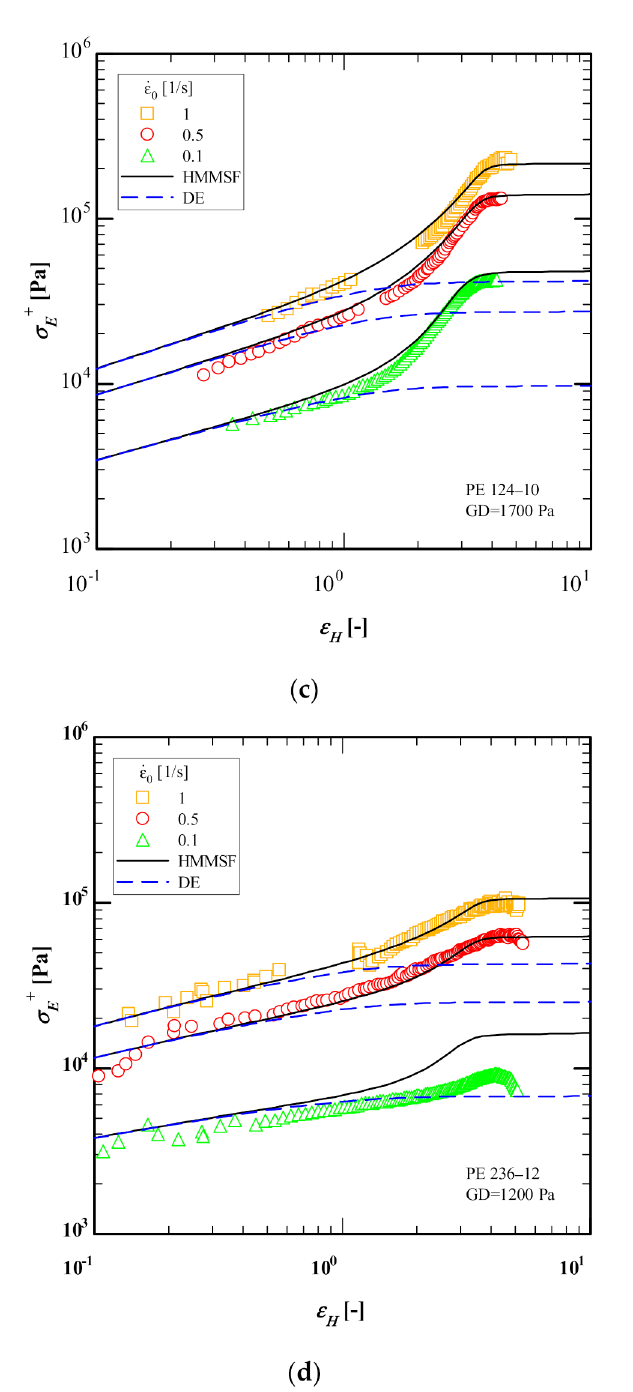
Figure 5. Comparison between data (symbols) of the extensional stress as a function of Hencky strain of ( a ) PE 191-8, ( b ) PE 127-9, ( c ) PE 124-10 and ( d ) PE 236-12 at 160 ◦ C with predictions of the Doi-Edwards (DE) model (blue dash lines) and the HMMSF model (Equations (4)–(6)) (continuous black lines) using the IRIS software